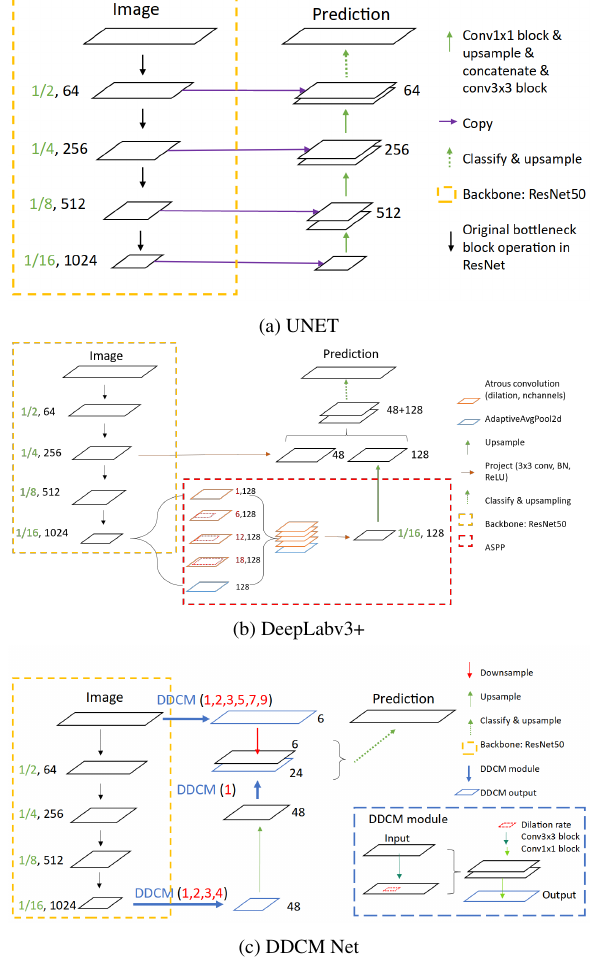
Figure 1. Architecture illustration of a) UNET, b) DeepLabv3+ and c) DDCM-Net. Upsample refers to bilinear upsampling. Backbone feature extraction is denoted by yellow dashed boxes. Model specific modules are denoted by colored dashed boxes. The size of feature maps are noted as fraction of its original size and reflected by the size of the planes. The numbers in green denotes image scale, red denotes dilation rate and black denotes number of feature